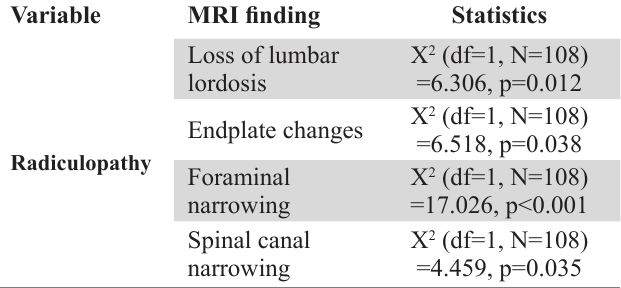
Table 2. Associations between radiculopathy and MRI findings